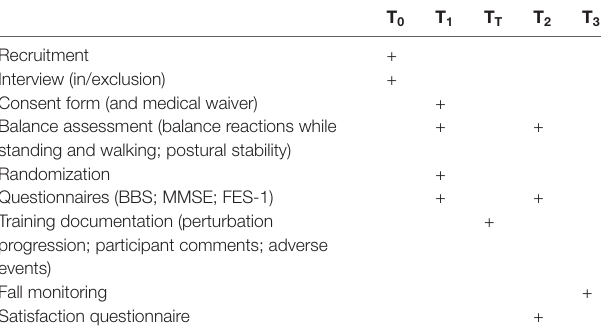
TABLE 1 | Flowchart—overview of outcome measurements and time of